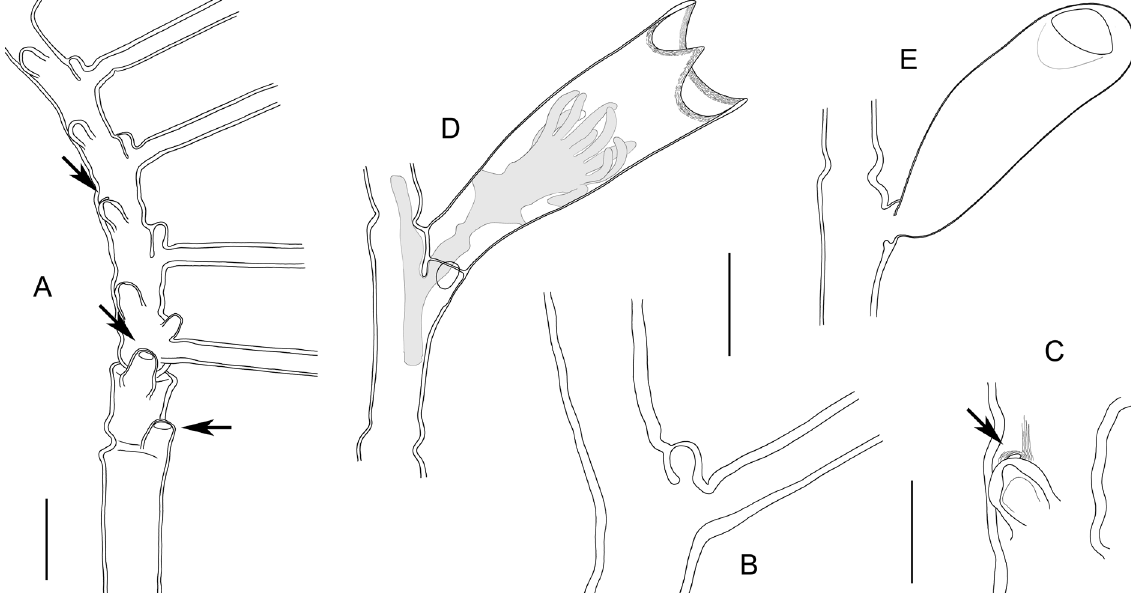
Fig. 18. Tuberocaulus scorpioides (Vervoort, 1993) gen. et comb. nov. A–E . Junction between proximal and distal parts of stem (A), showing apically- or axillary-opened nematothecae (arrowheads), detail of insertion of cladium (B), upper stem nematotheca with aperture in axil (C, arrowhead), hydrotheca (D), gonotheca (E), all from sample MNHN-IK-2015-400. Scale bars: A = 1 mm; B–E =